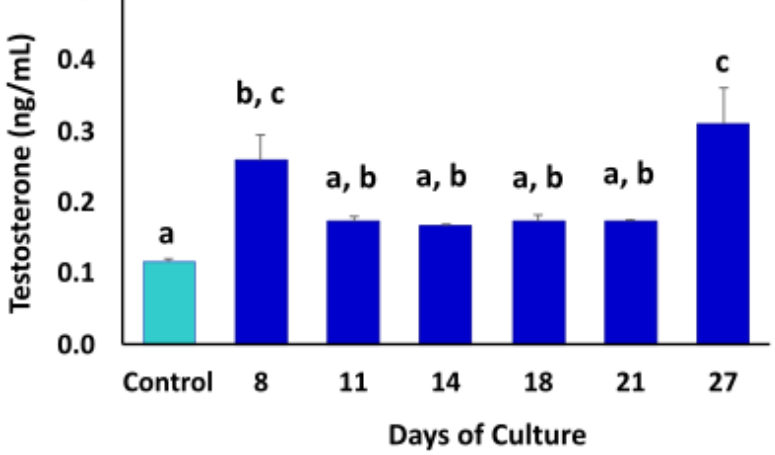
Figure 7. Chemiluminescence analysis of testosterone concentrations in culture medium of TOs during culture period. Higher ( p < 0.05) levels of testosterone were detected at days 8 and 27 of culture. Fresh culture medium was used as control. Data were expressed as the mean ± SEM ( n = 3). Superscripts (a–c) indicate significant ( p < 0.05) differences in testosterone concentrations in TO culture media between days of